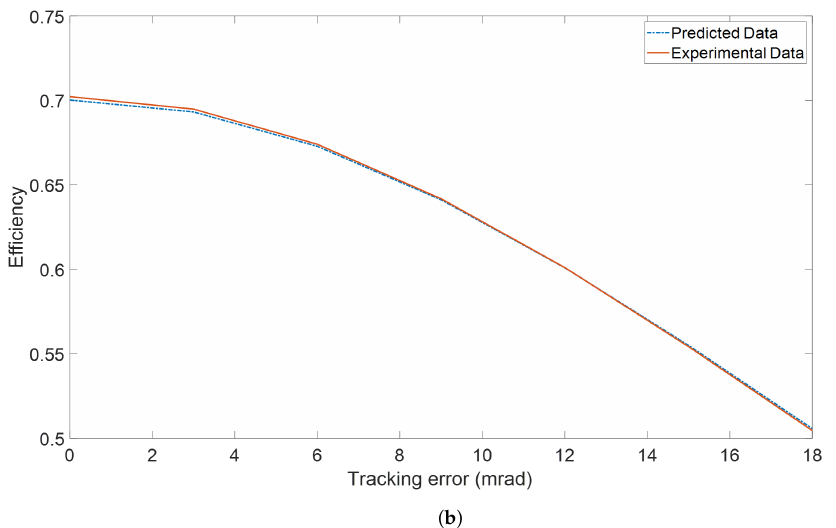
Figure 1. Comparison between predicted result and experimental data; ( a ) The intercept factor of parabolic trough solar system calculated by program and SolTrace under different tracking error. ( b ) The efficiency of parabolic trough solar system calculated by program and SolTrace under different tracking error.